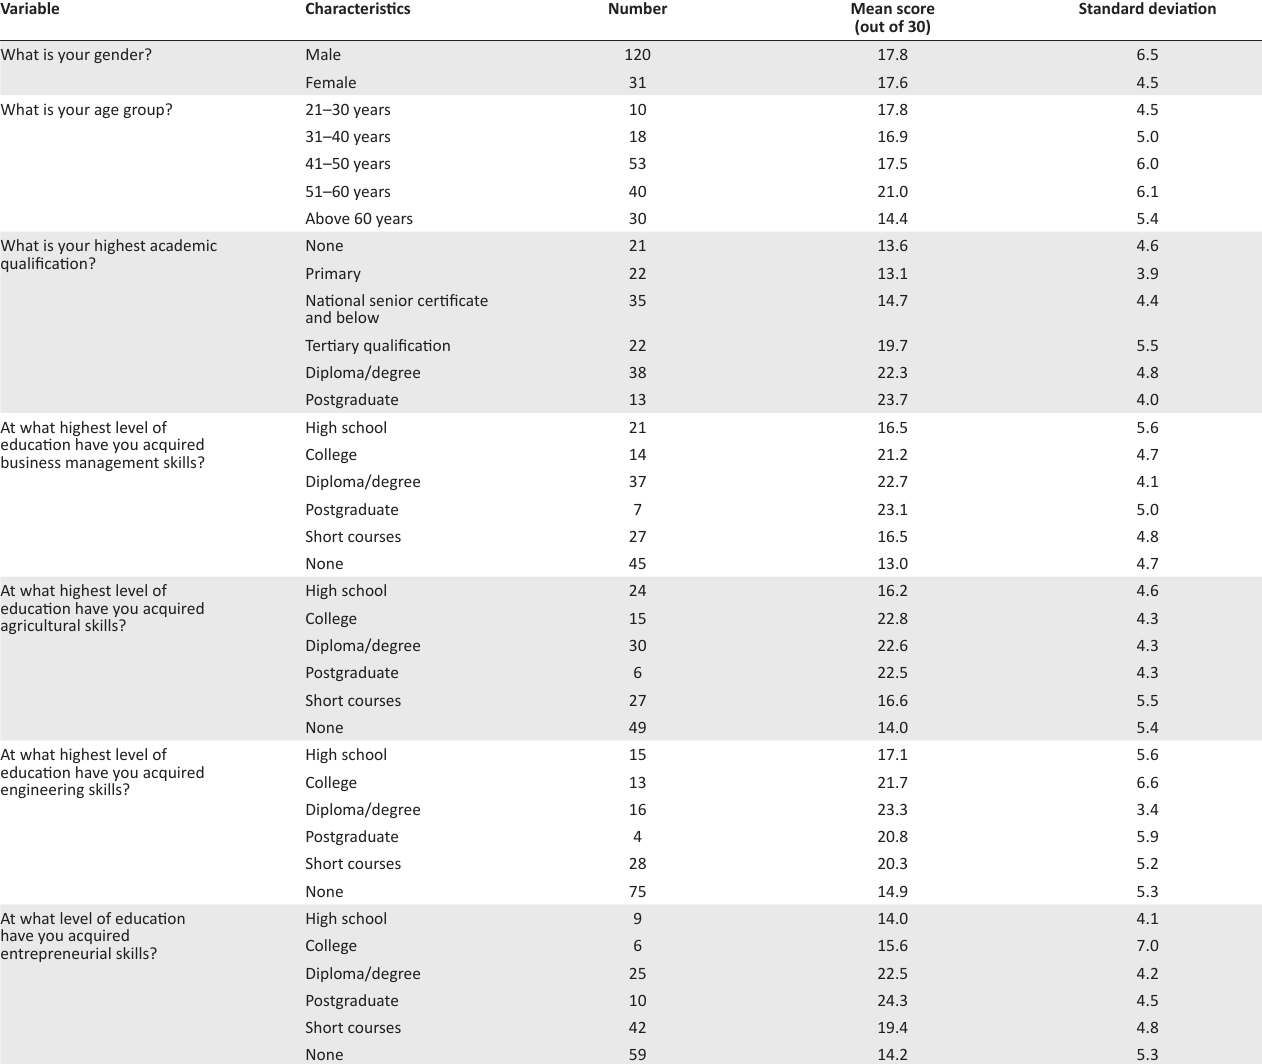
TABLE 2: Demographic characteristics of owners or managers of small-scale agricultural businesses.